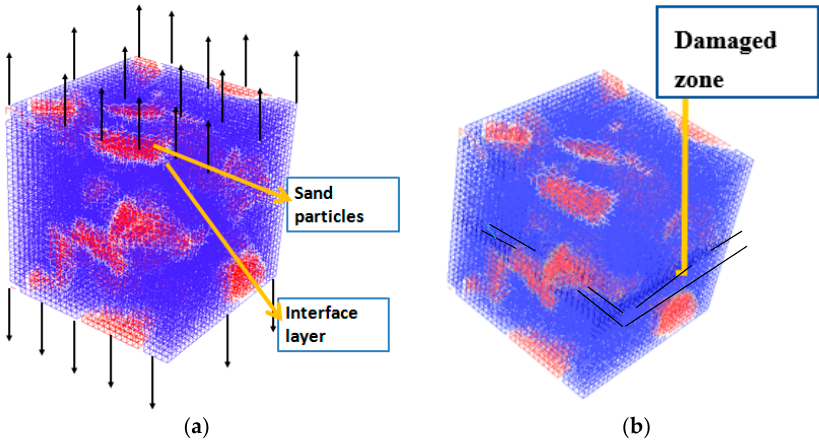
Figure 9. ( a ) Uniaxial tension analysis on the mortar-s scale (cement paste in blue, sand particles in red, and interface layer in white); and ( b ) the resulting damaged zone on mortar-s scale (damaged zone is underlined in black).